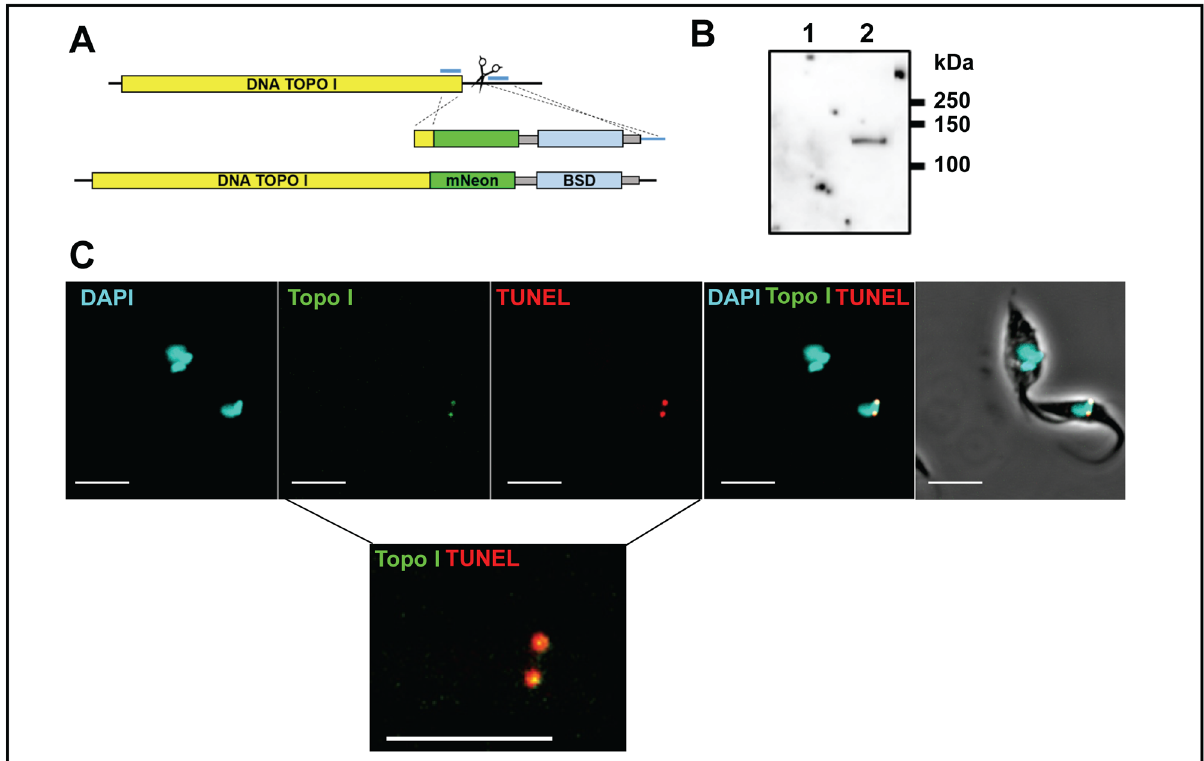
Fig 8. CRISPR/Cas9 mediated tagging and localisation of DNA topoisomerase 1A. A . Map of the DNA topoisomerase 1A gene. The single sgRNA/ Cas9 cleavage site is indicated by scissors. Blue lines indicate the positions of sequences corresponding to the 30 bp homologous arms in the repair fragment. The lower image shows the edited gene containing the 3’ fusion with mNeonGreen and the position of the selectable blasticidin (BSD) resistance gene. Grey boxes indicate sequences required for mRNA processing. B. Western blot showing the expression of the tagged DNA topoisomerase 1A. Lane 1, the CL-cas9 parental strain with an untagged locus; Lane 2, mNeonGreen tagged cell line showing a single band of the expected size (120 kDa). The blot was probed with anti-mNeonGreen (ChromoTek GmbH) C. Images showing that fluorescence is restricted to antipodal sites on the kinetoplast in parasites expressing mNeonGreen tagged DNA topoisomerase 1A. These sites coincide with regions of TUNEL positivity (Methods). Note that the upper parasite in the image, where the kinetoplasts have replicated and segregated, is negative for both mNeonGreen and TUNEL staining. The lower inset shows a magnified image where the mNeonGreen/TUNEL staining patterns are merged. Co- localisation appears as yellow. The bar indicates 5μm.